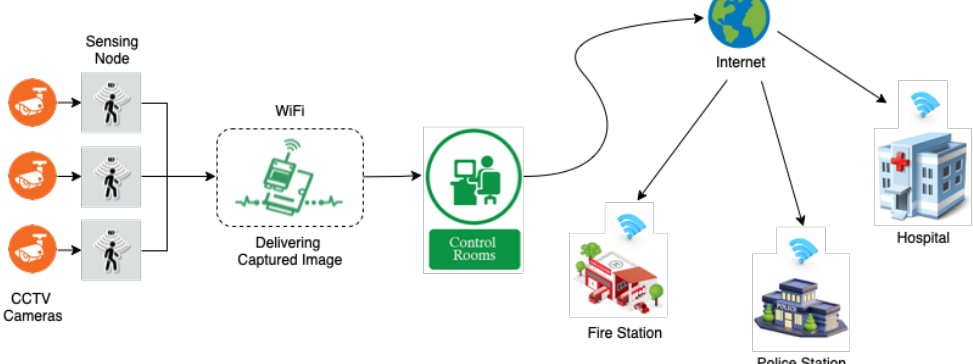
Figure 1. Reprinted from Ref. [7]: Framework of data transmission in CCTV system.